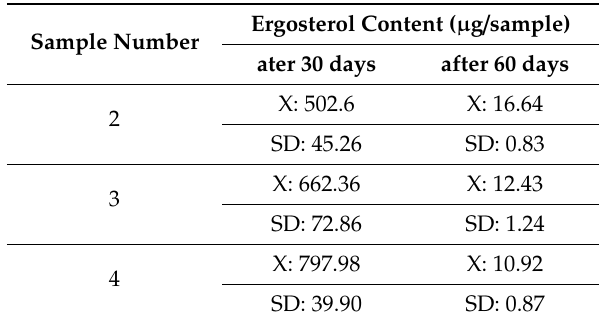
Figure 5. FTIR spectra of sulfur concrete after incubation with bacteria (blue—sulfur concrete before incubation, purple—after 1 month of incubation with bacteria, red—after 2 months of incubation with bacteria). Table 8. Ergosterol content on sulfur concrete samples after incubation with